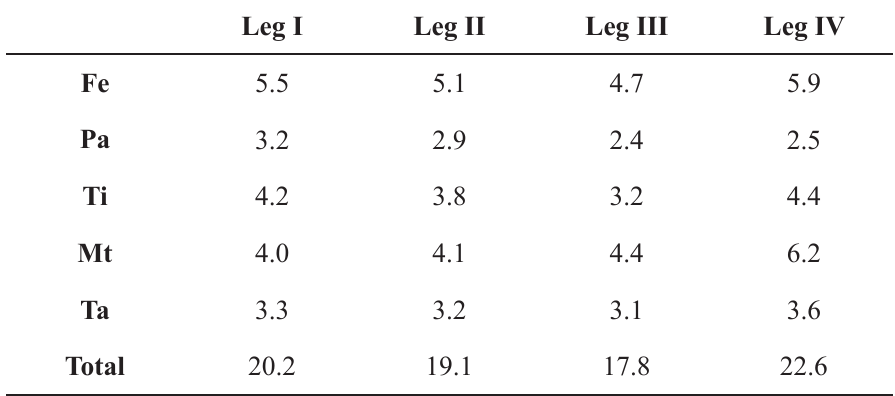
Table 1. Diplura macrura (C.L. Koch, 1841), ♂. Length of left leg articles (dorsal